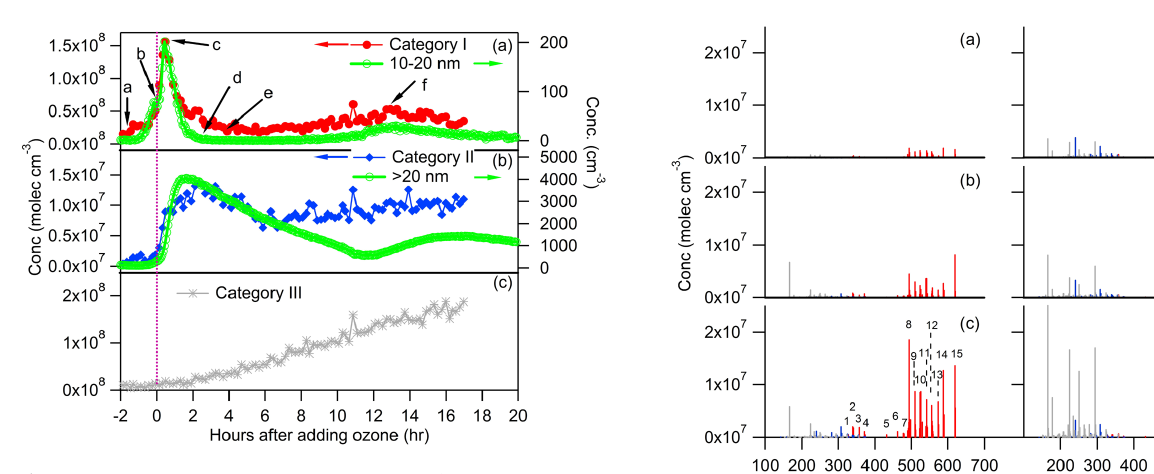
Fig. 3. Time-dependent total concentrations of the three category (I–III) products measured with the Cluster CIMS, along with the total concentrations of two category particles (10–20nm particles and particles larger than 20nm measured with the SMPS for E1). (a) Category I products and 10–20nm particles, points a–f corre- spond to times a–f in Fig. 1b; (b) Category II products and particles larger than 20nm; (c) Category III.